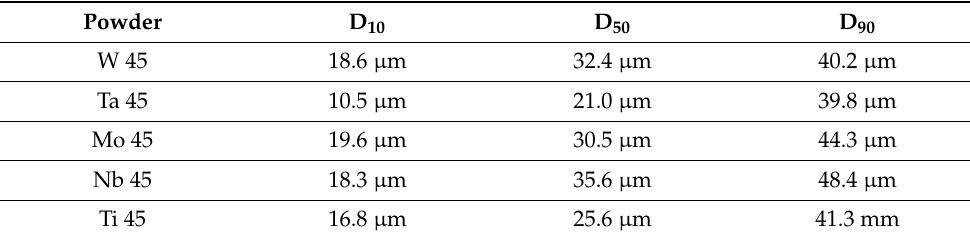
Table 1. Particle size distribution determined by laser